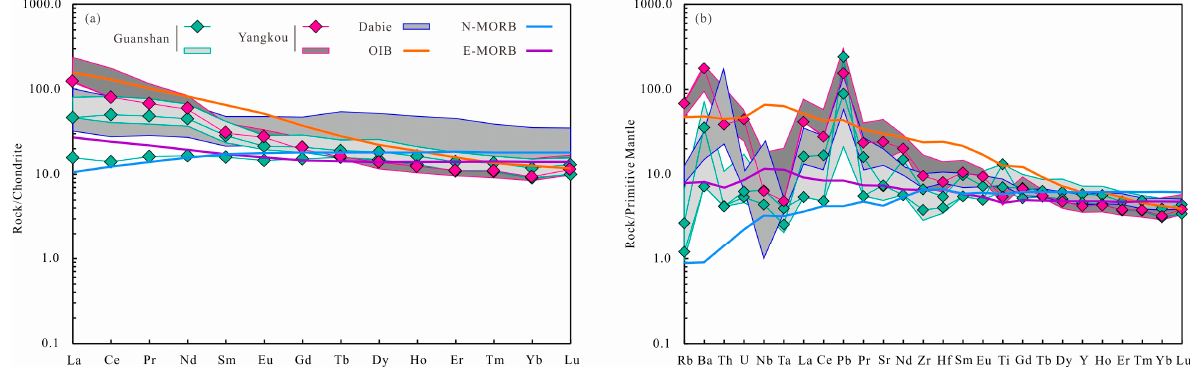
Figure 4. ( a ) Chondrite-normalized rare earth element patterns and ( b ) Primitive mantle-normalized trace element patterns for eclogites from the Guanshan and Yangkou area. Chondrite, primitive mantle, N-MORB, E-MORB and OIB are from Sun and McDonough [44]. Shaded areas of Yangkou are from Yuan et al. [13] and Guanshan are from our unpublished data.